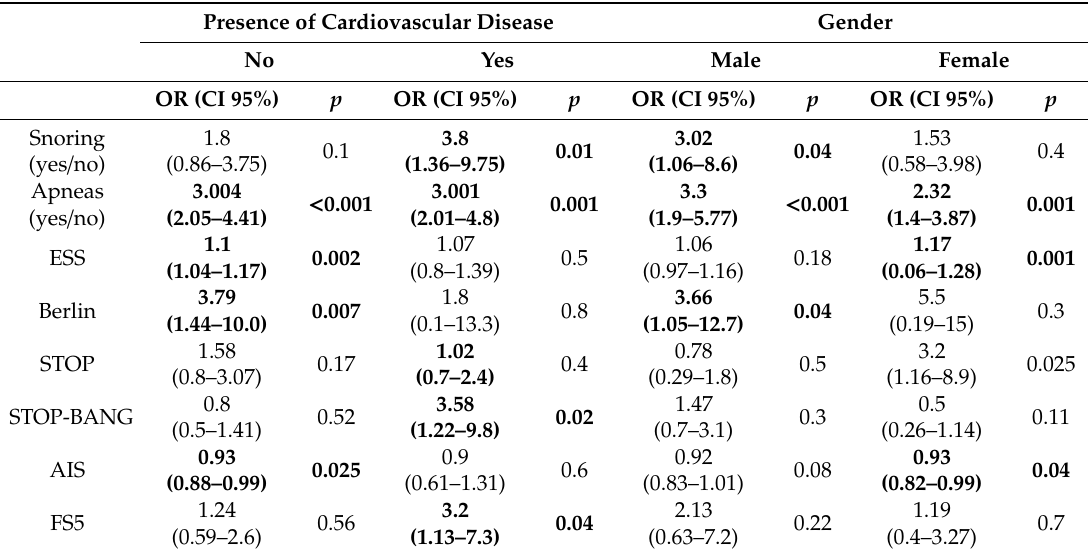
Table 7. Multiple regression analysis * for the associations of sleep symptoms and sleep questionnaires with OSA (REI > 15) stratified by gender and cardiovascular